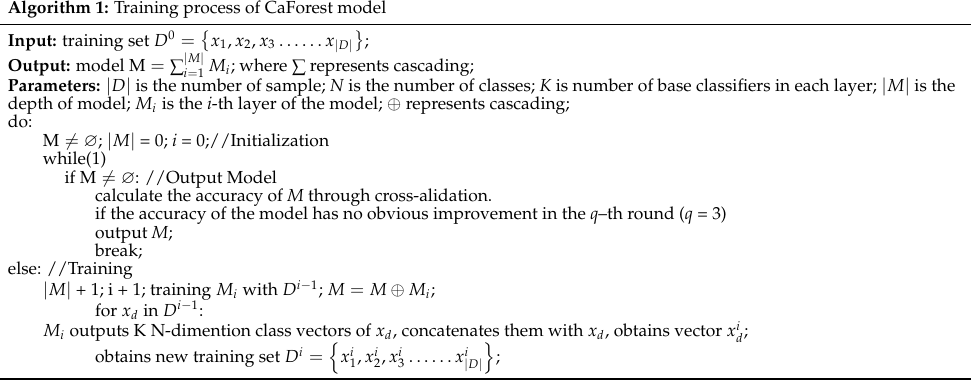
Algorithm 1: Training process of CaForest model